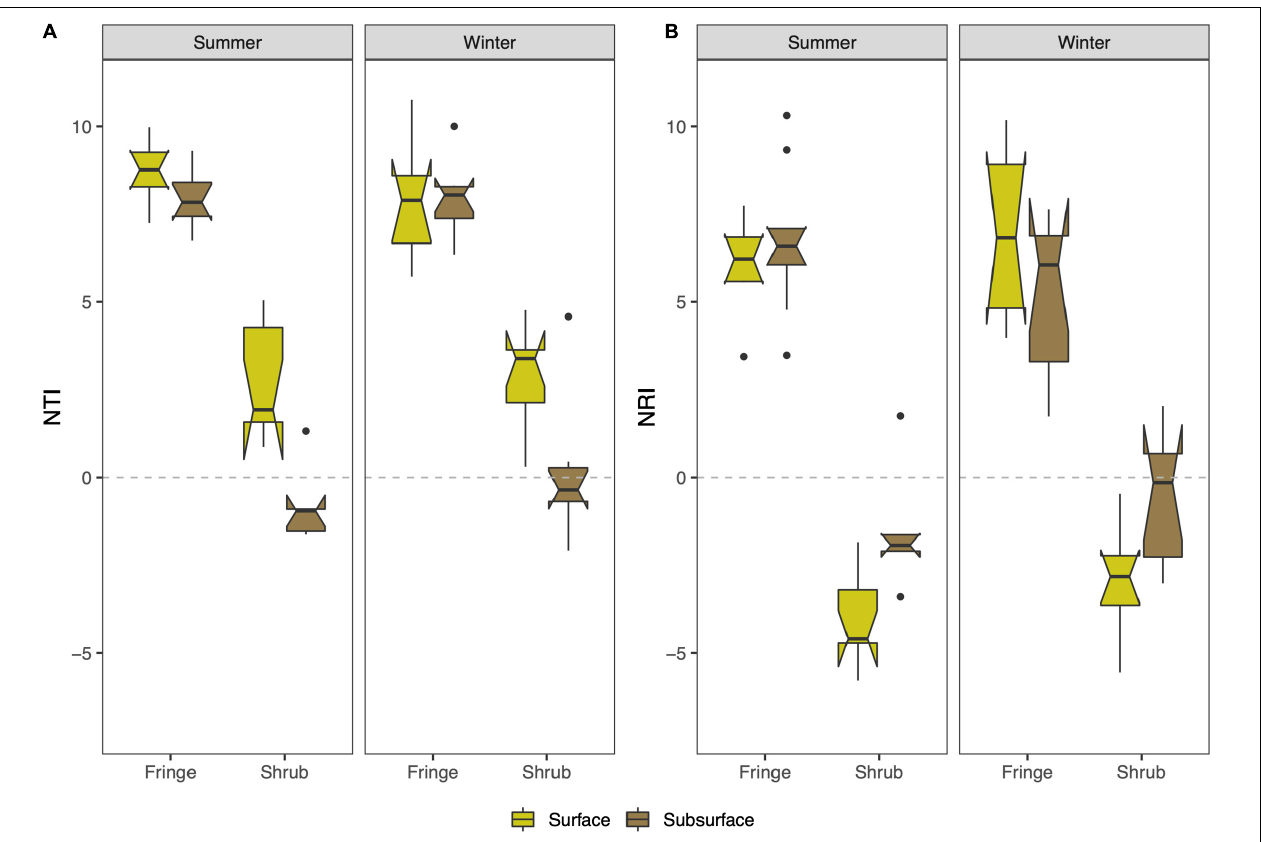
FIGURE 4 | Patterns of phylogenetic diversity structure across seasons and location factors. (A) Nearest taxon index (NTI) is calculated from the mean distance to the nearest neighbor on the phylogenetic tree. (B) Net relatedness index (NRI) computes the mean pairwise distances between each taxon on the phylogenetic tree. Both indexes are fitted against null models to give a standardized measure of effect size of phylogenetic clustering or overdispersion. The boxplots indicate the median with the interquartile range (IQR) between the 25th and the 75th percentile and the whiskers extend 1.5*IQR. Boxes were plotted with the notch ( ± 1.58*IQR/sqrt[n]) to display likely statistical significance if notches do not overlap.